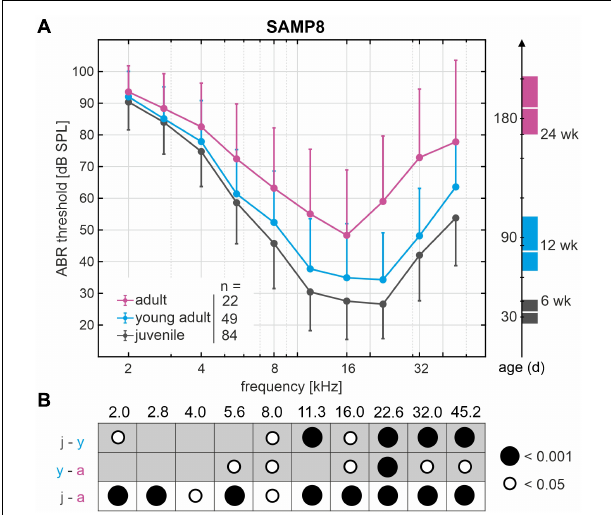
FIGURE 2 | Decline of hearing acuity over age in SAMP8 mice as assessed by auditory brainstem response (ABR) thresholds. (A) Mean and standard deviation of ABR thresholds from accumulated control groups (reference cohort) divided into three age groups: juvenile (black, n = 84), young adult (blue, n = 49), and adult (pink, n = 22). The right graph shows mean age and age range in days for each group: juvenile (black, mean 34 days, range 25–45 days), young adult (blue, mean 80 days, range 65–105 days), and adult (pink, mean 188 days, range 170–210 days). (B) Graphical representation of significant differences (white and black circles represent p < 0.05 and p < 0.001, respectively) from pairwise comparisons of ABR thresholds between age groups (j, juvenile; y, young adult; a, adult) for each frequency in